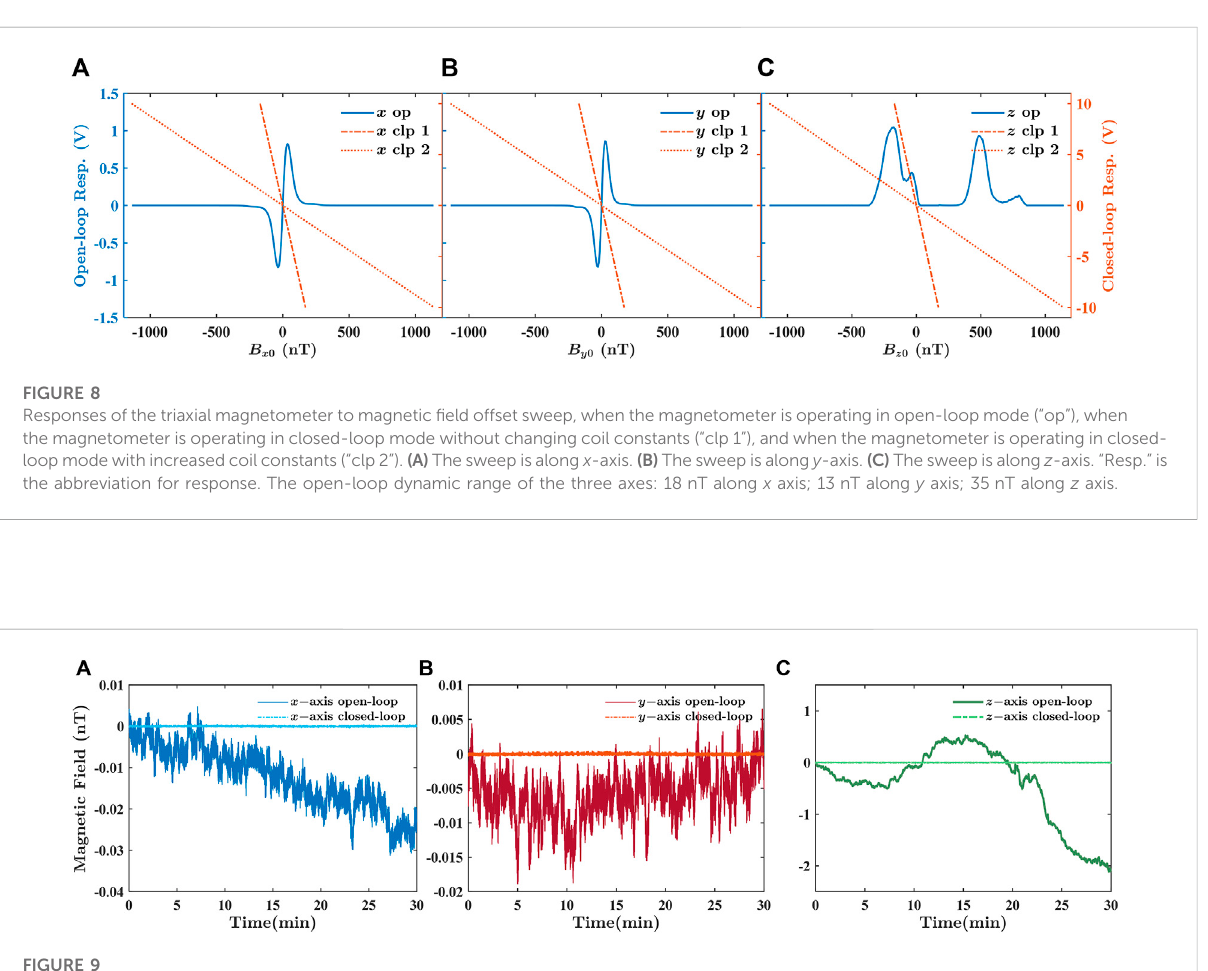
FIGURE 9 The triaxial magnetic fi eld sensed by the magnetometer when it is operating in open loop or in closed loop for 30 min recording time. (A) The fi eld sensed along x -axis. (B) The fi eld sensed along y -axis. (C) The fi eld sensed along z -axis. With closed-loop control, the triaxial sensed magnetic fi elds are kept locked at zero, with variations less than 1% of that with open